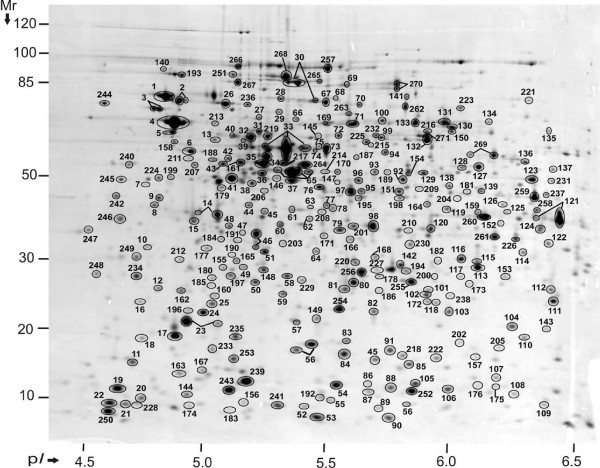
Annotated proteome map of 2D gel. SD1 proteins were analyzed by 2-DE in the pH range 4 – 7. 271 proteins mapped to the gel by 2-DE/MS are represented by spot numbers. 2-DE protein abundances of 255 proteins matched to unique spots were correlated with APEX abundances.